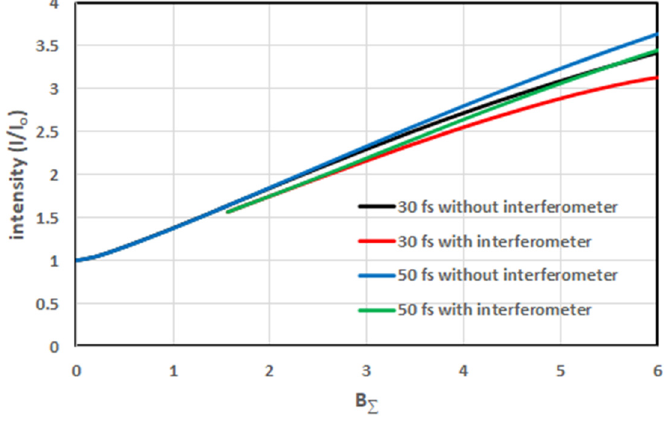
Figure 5. Output pulse intensity as a function of B- integral.